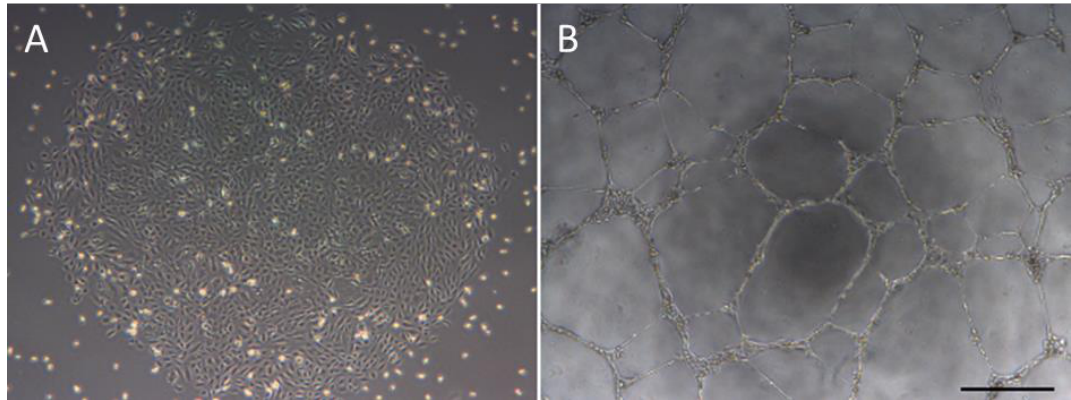
Figure 1. Morphology of endothelial-colony-forming cells (ECFCs) and their ability to form tubes. A = cobblestone morphology of ECFC colonies. B = In vitro tubulogenesis assay showing the ability of ECFCs to form a network of tubes. Scale bar = 500 µm.